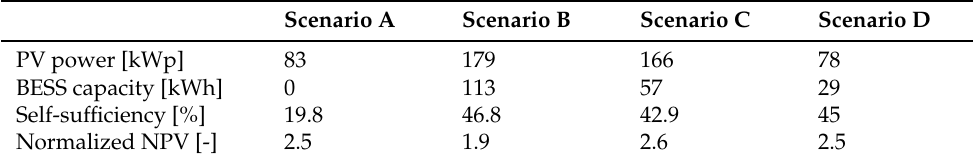
Table 3. Optimization results for the four scenarios considering the NPV cost